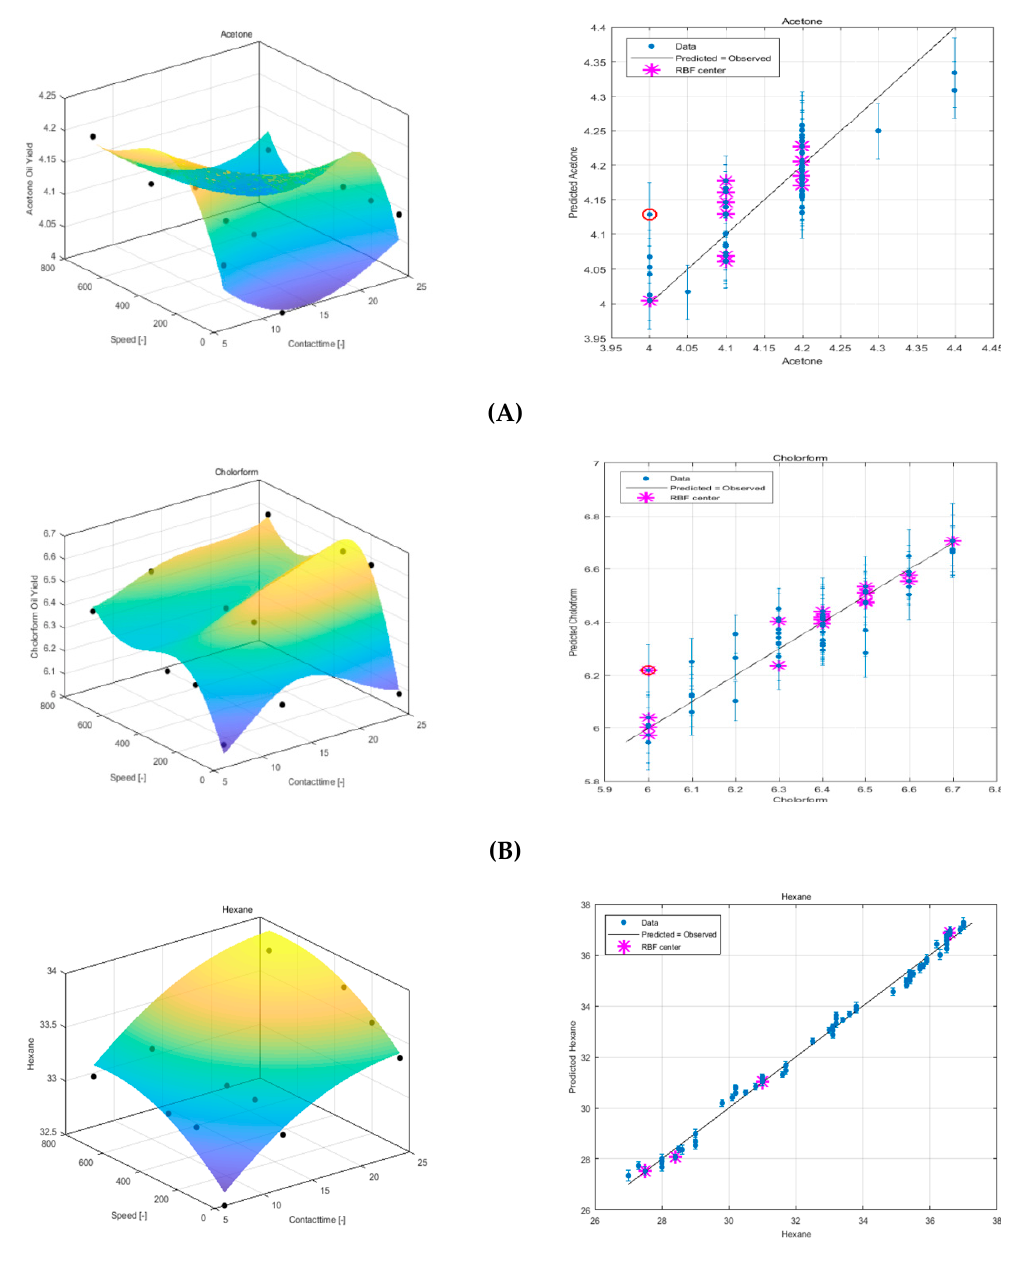
Figure 4. Response surface plot using QRBF and experimental versus predicted data for sesame seed oil extraction using ( A ) acetone, ( B ) chloroform, and ( C ) hexane.